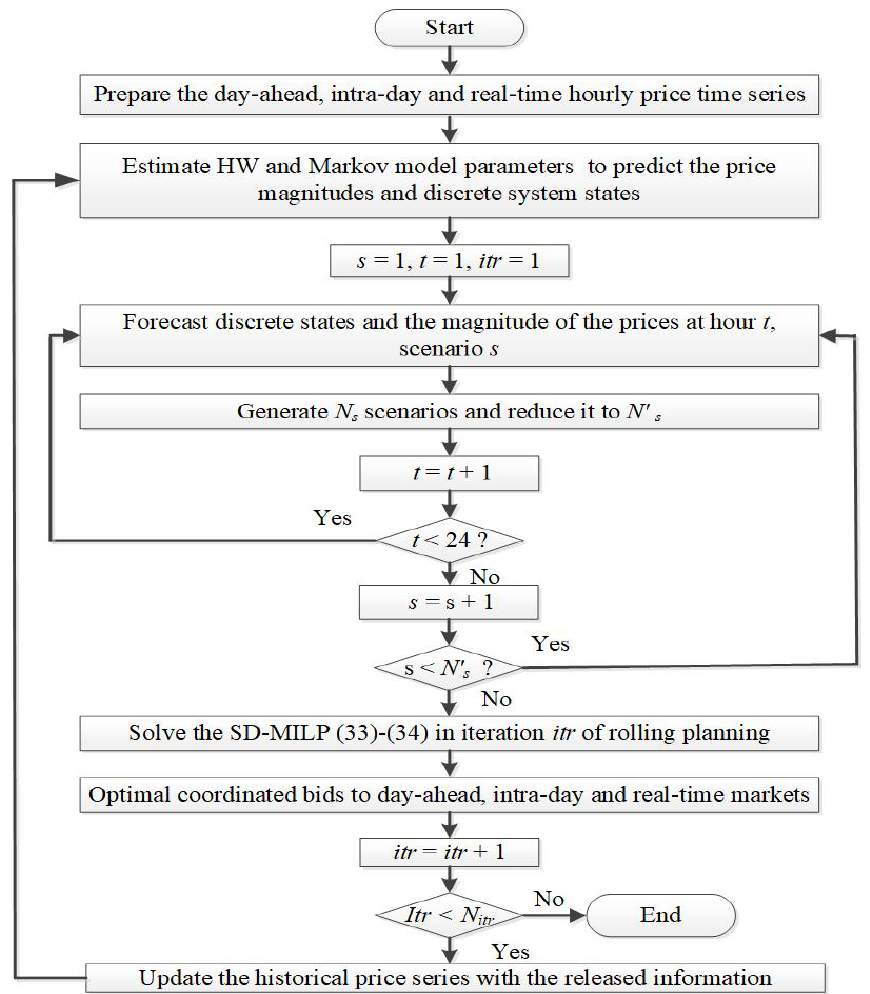
Figure 3. Flowchart of the proposed algorithm for deriving the optimal coordinated bidding curves to day-ahead, intra-day, and real-time